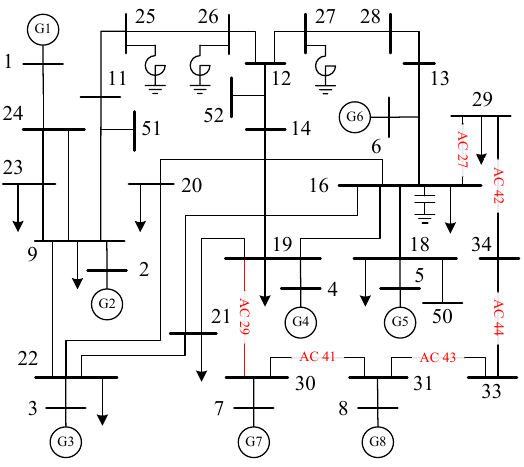
Figure 3. The single line diagram of the CEPRI36 benchmark